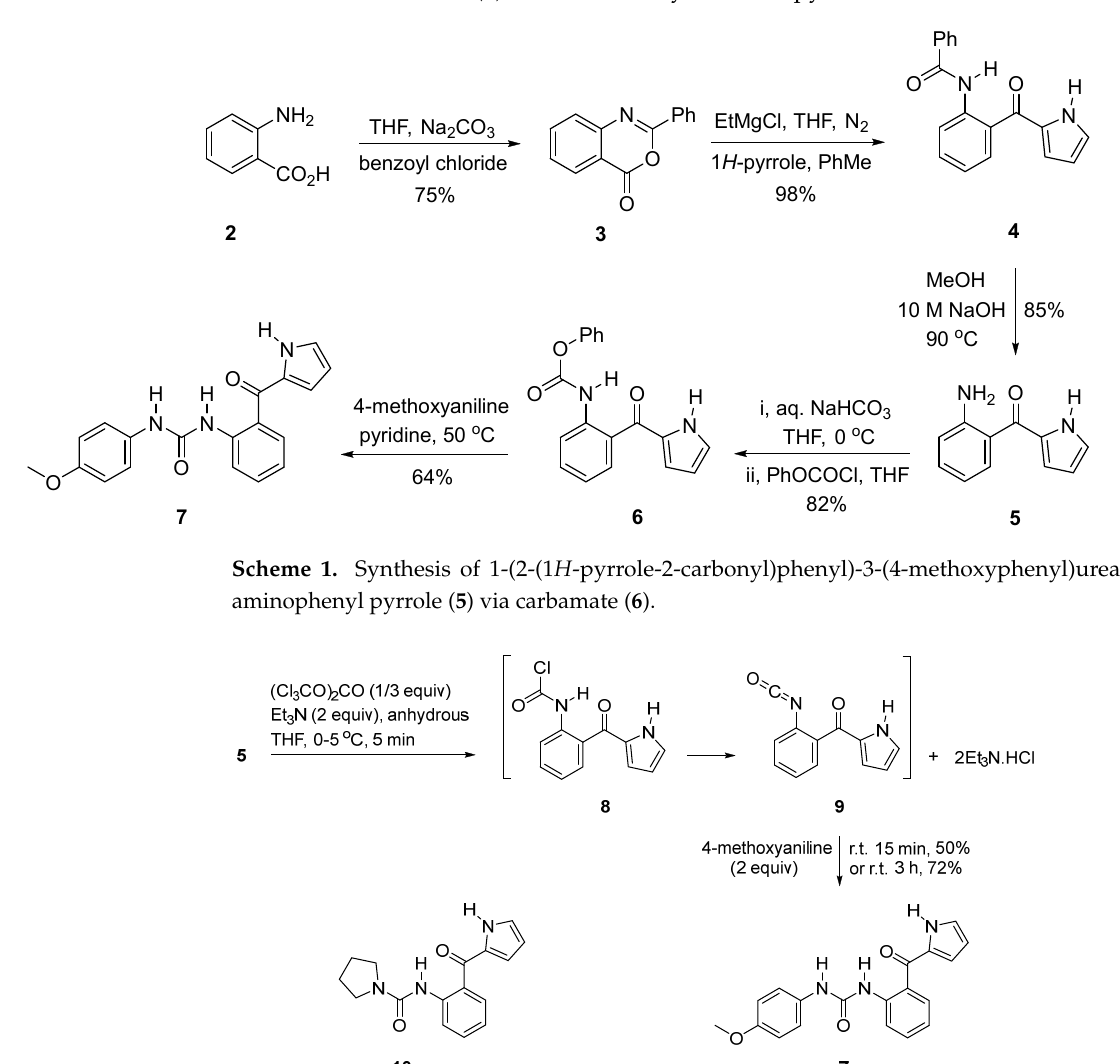
Scheme 2. Synthesis of 1-(2-(1 H -pyrrole-2-carbonyl)phenyl)-3-(4-methoxyphenyl)urea ( 7 ) directly from aminophenyl pyrrole ( 5